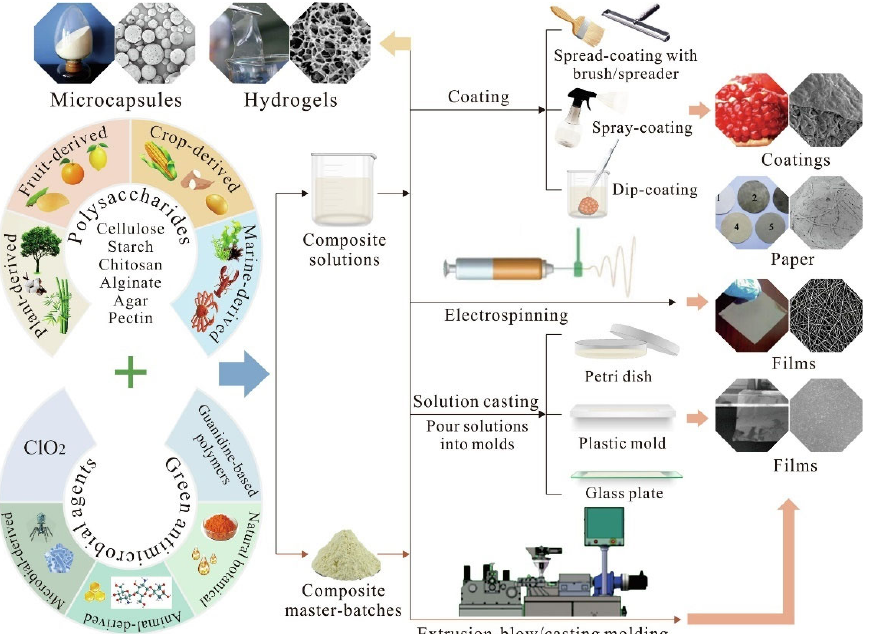
Figure 5. Different applications of green antimicrobial compounds to polysaccharide-based packaging (reproduced with copyright permission from Zhao et al. [107]).